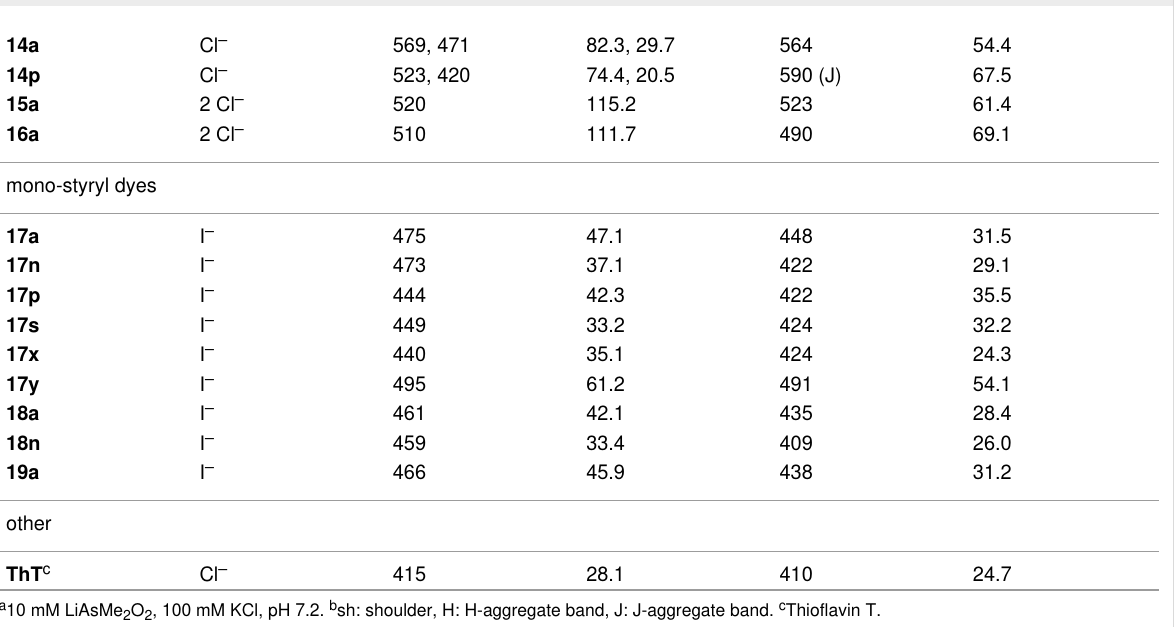
Table 1: Positions of maxima and intensity of long-wavelength absorption bands of dyes in MeOH and K-100 aqueous buffer. a (continued)